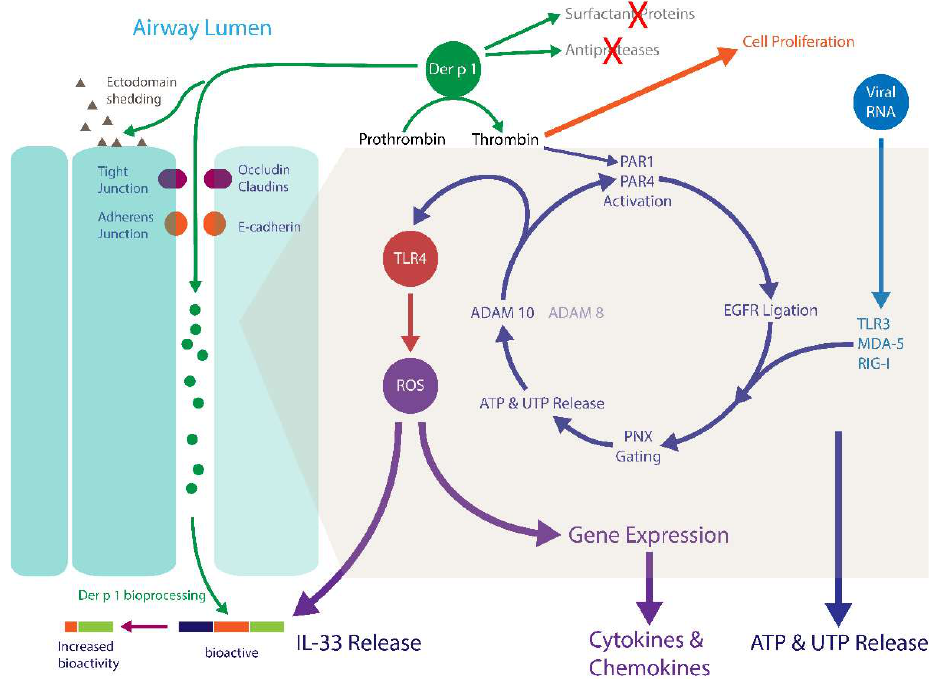
Figure 5. Schematic representation of a range of innate events triggered in airway epithelial cells by group 1 HDM allergens such as Der p 1. Proteolytic cleavage of tight junctions and adherens junctions facilitates transepithelial allergen delivery. Prothrombinase activity of the allergen leads to the canonical cleavage of PAR1 and PAR4, initiating a signalling cycle when enables the activation of TLR4 with the subsequent generation of ROS and the upregulation of inflammatory gene expression. Inactivation of airway defences (antiproteases and surfactant proteins) augment the effects outlined above. The release of the alarmin IL-33 from epithelial cells is facilitated by ROS and ATP and can be converted to a super-active form following cleavage by Der p 1.